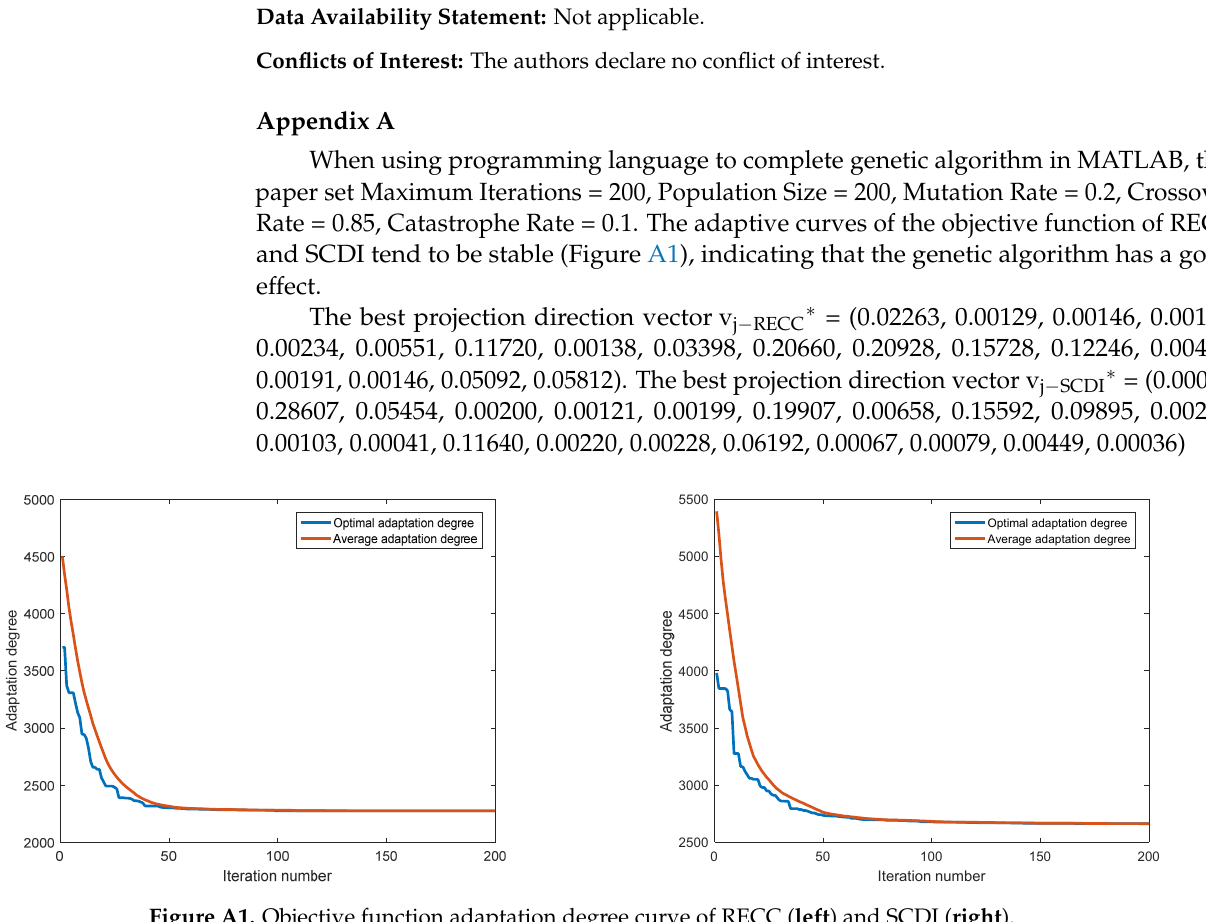
Figure A1. Objective function adaptation degree curve of RECC ( left ) and SCDI ( right ). Table A1. RECC, SCDI and decoupling index of cities in Hubei during 2009–2018.